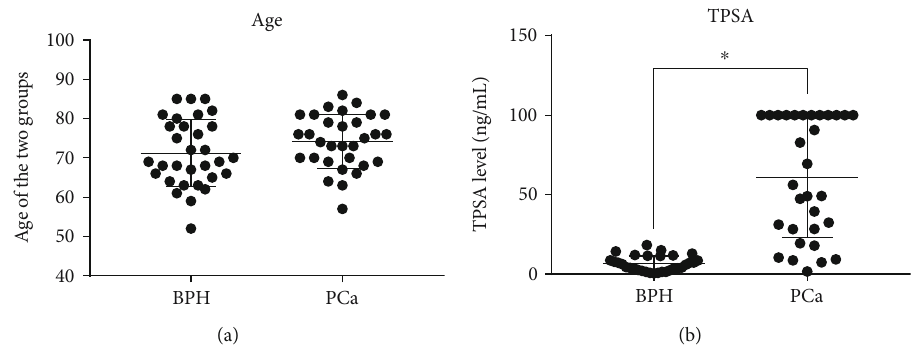
Figure 1: The ages and TPSA levels in the PCa and BPH groups: (a) age; (b) TPSA level. ∗ P < 0 : 05 ; n = 31 .